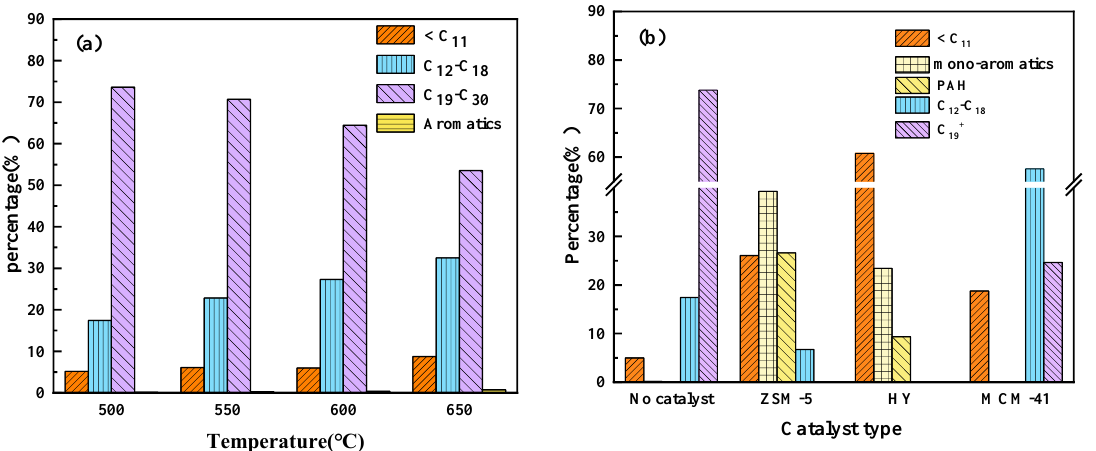
Figure 5. Distribution of the oil products in terms of carbon number ( a ) Liquid product composition of LDPE at different temperatures; ( b ) Liquid product composition of LDPE at different catalysts.